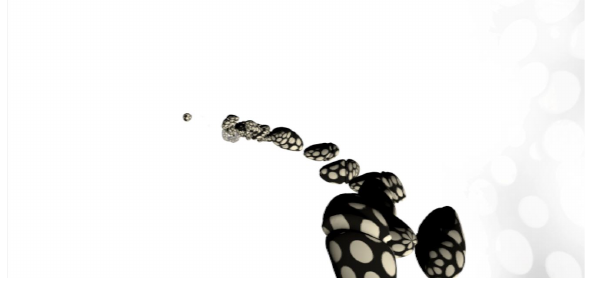
Figure 8. AudioVirtualizer scene 3b